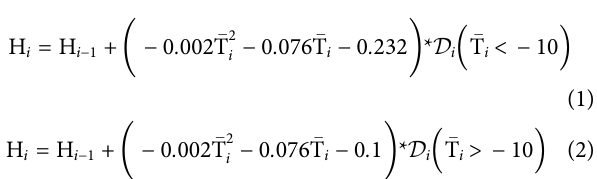
Frontiers in Environmental Science |